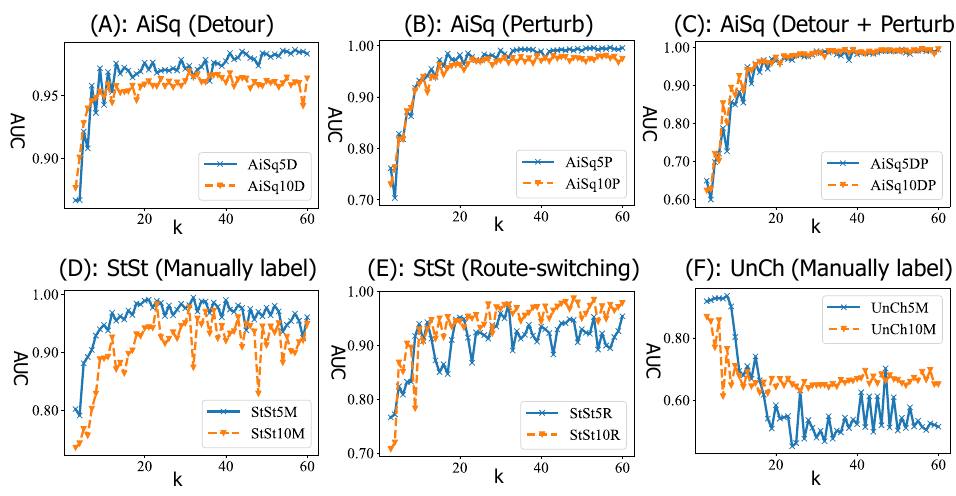
the distance was short as per the UnCh dataset, a smaller k could bring better results. This indicated the optimal k was related to the distance of trajectories. It was observed that the distance between the source and the destination affects the stability of the results by visualizing the gradient of the AUC curves.